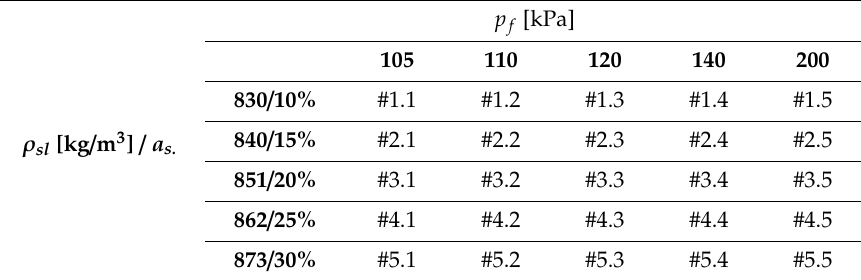
Table 4. Simulated cases information. Each of the below cases were investigated for v 0 = 0.07 m/s and different particle’s diameters between 0.2–1.4 mm